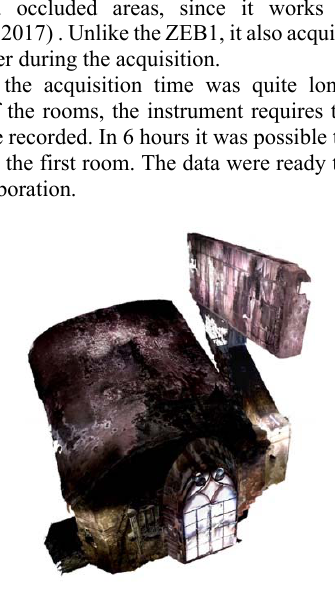
Figure 7. The DOT DPI 8 point cloud, 106.490.995 points, 18 GB.